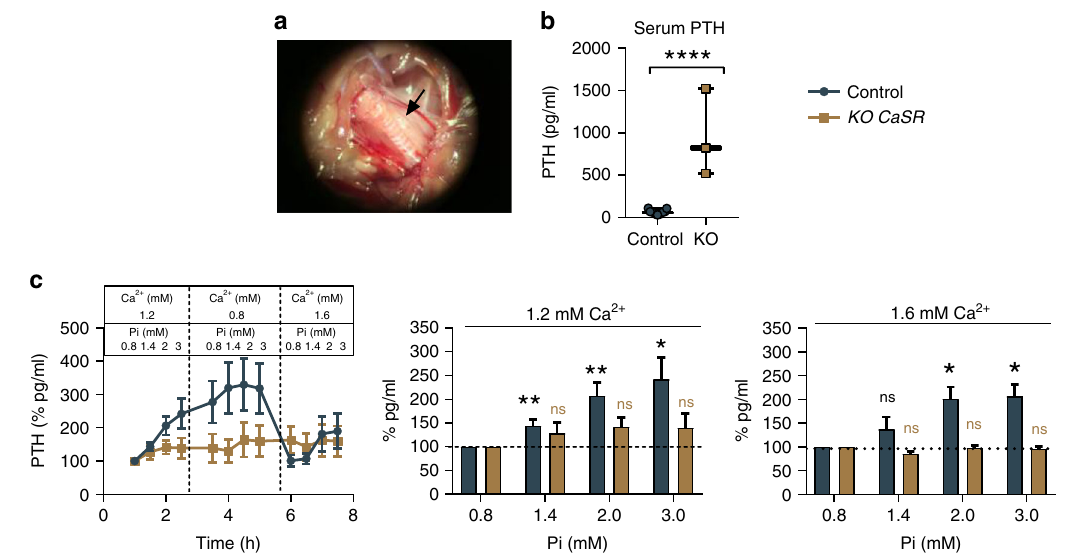
Fig. 4 Pi increases murine PTH secretion via the CaSR. a Magni fi ed mouse parathyroid gland before dissection in a 10-day-old control mouse. b Serum PTH levels measured from control and KO Casr mice before dissection. Data shown as median and min. to max. range (WT N = 11 and KO Casr N = 3). **** P < 0.0001 by unpaired t test. c Effect of pathophysiologic Pi exposure at different Ca 2 + concentrations on PTH secretion in freshly isolated parathyroid glands from 7- to 10-day-old control. WT glands (from four different litters) were sequentially exposed to normal Ca 2 + (1.2 mM Ca 2 + ; N = 11), low Ca 2 + (0.8 mM Ca 2 + ; N = 7 and 0.6 mM; N = 4), and high Ca 2 + (1.6 mM Ca 2 + ; N = 7). The KO Casr glands were exposed to 1.2, 0.8, and then 1.6 mM Ca 2 + in turn ( N = 3). PTH secretion measured every 30 min and normalized to baseline conditions (0.8 mM Pi/1.2mM Ca 2 + ) in the time course (left). For bar graphs, data normalized to 0.8 mM Pi at their respective Ca 2 + concentration. Data shown as %mean ± SEM. ns not signi fi cant, * P < 0.05, ** P < 0.01 by RM-ANOVA (Dunnett ’ s multiple comparison test). Source data are provided as a Source Data fi